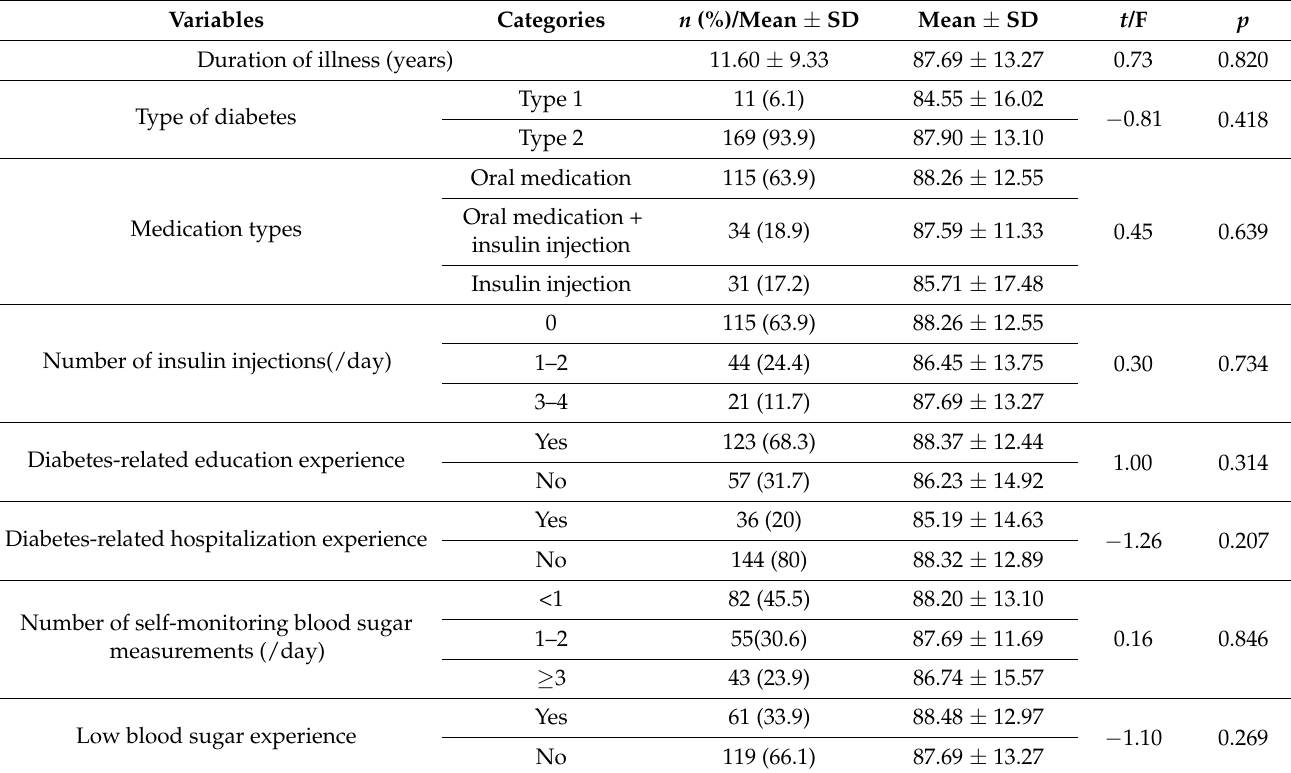
Table 2. Comparison of quality of life according to disease-related characteristics (N =